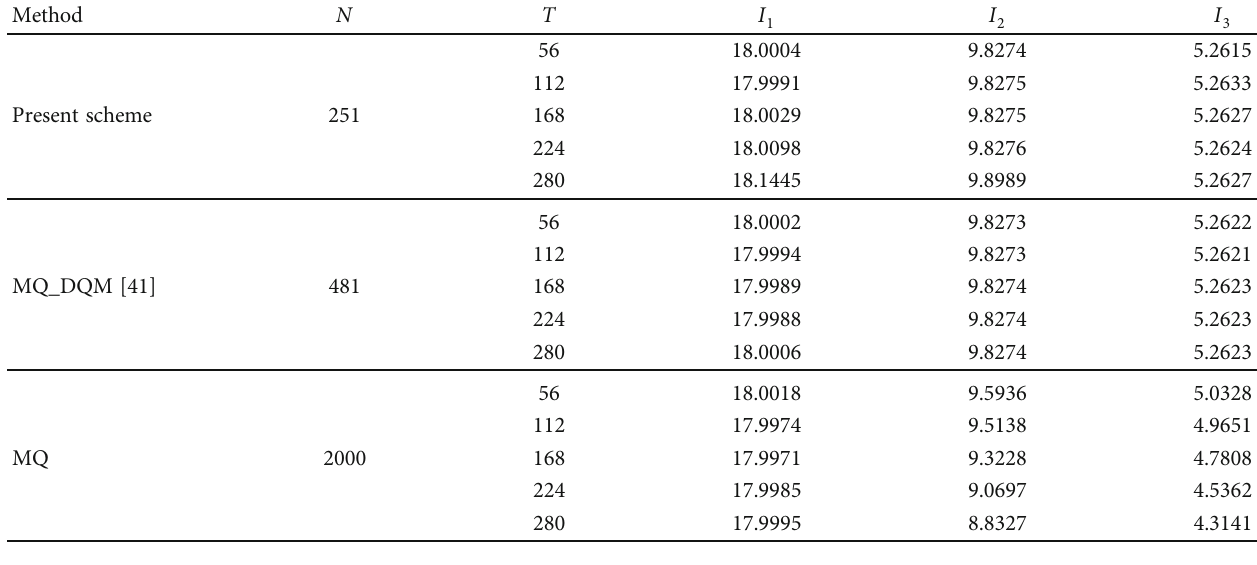
Table 5: Experimental evaluation of interaction of three solitons: Δ t = 0 : 1 :